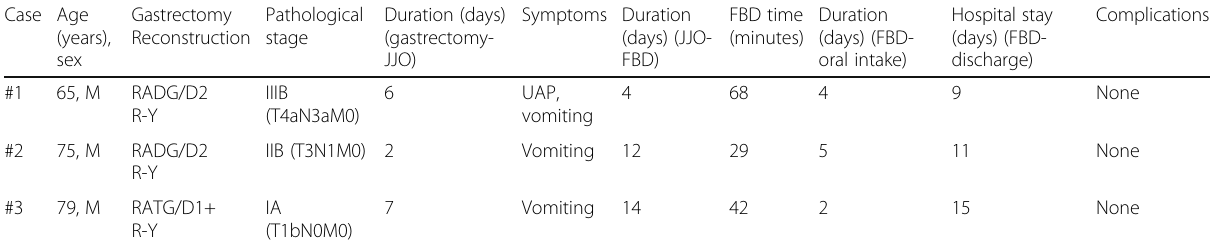
Table 1 Characteristics of the three patients with jejunojejunostomy obstruction after robot-assisted gastrectomy with Roux-en-Y reconstruction Case Age